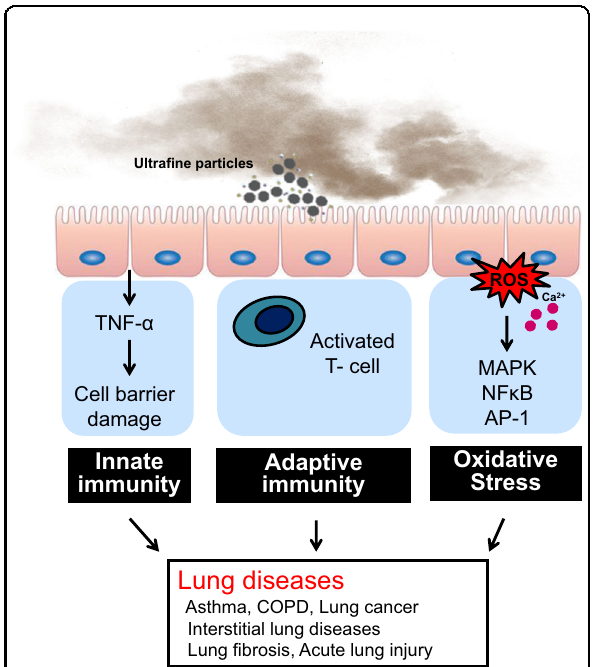
Fig. 1 The proposed mechanism of ultra fi ne particle (UFP)- induced lung diseases. PM causes the activation of oxidative stress and reactive oxygen species, innate immunity, adaptive immunity, and other mechanisms, leading to the development and exacerbation of respiratory diseases such as bronchial asthma, COPD, lung fi brosis, and lung